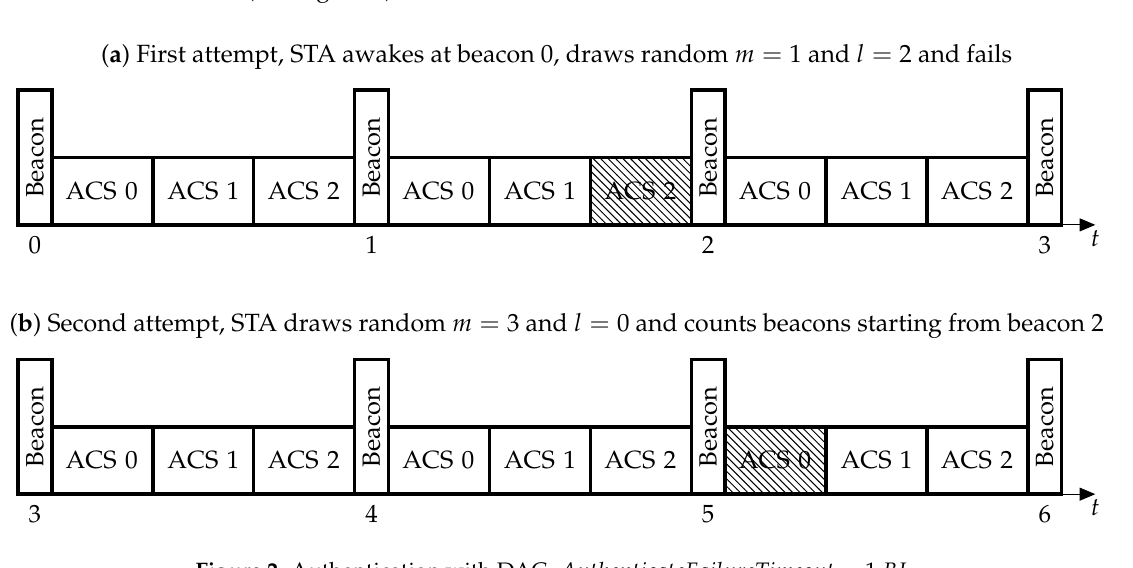
Figure 2. Authentication with DAC. AuthenticateFailureTimeout = 1 BI